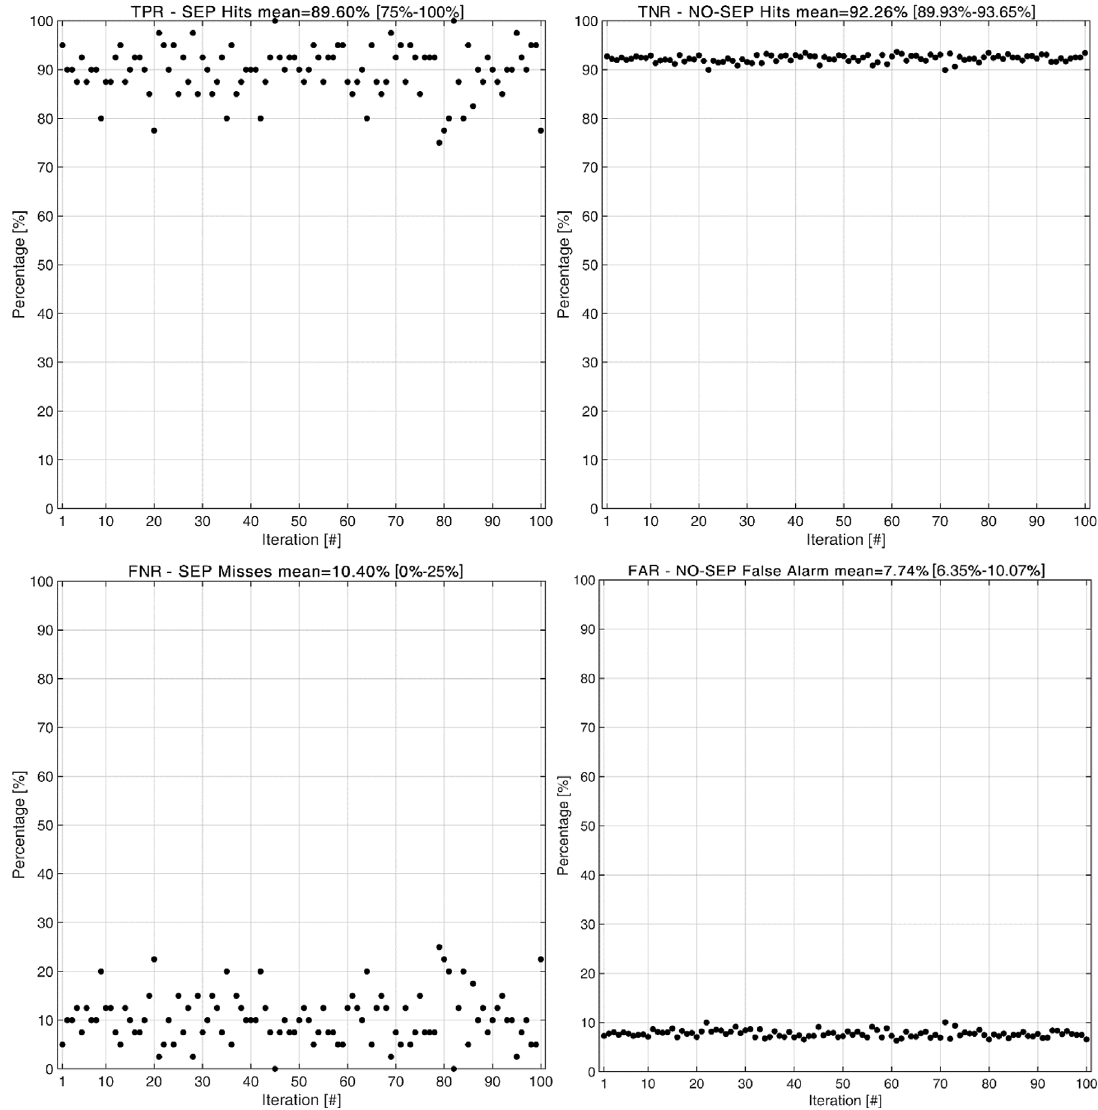
Fig. 3. Results from 100 iterations of random sampling-training-testing. Top panels: correct prediction rates for true positives (SEP occurred) and true negatives (no SEP). Bottom panels: wrong prediction rates for false negatives (missed SEP) and false